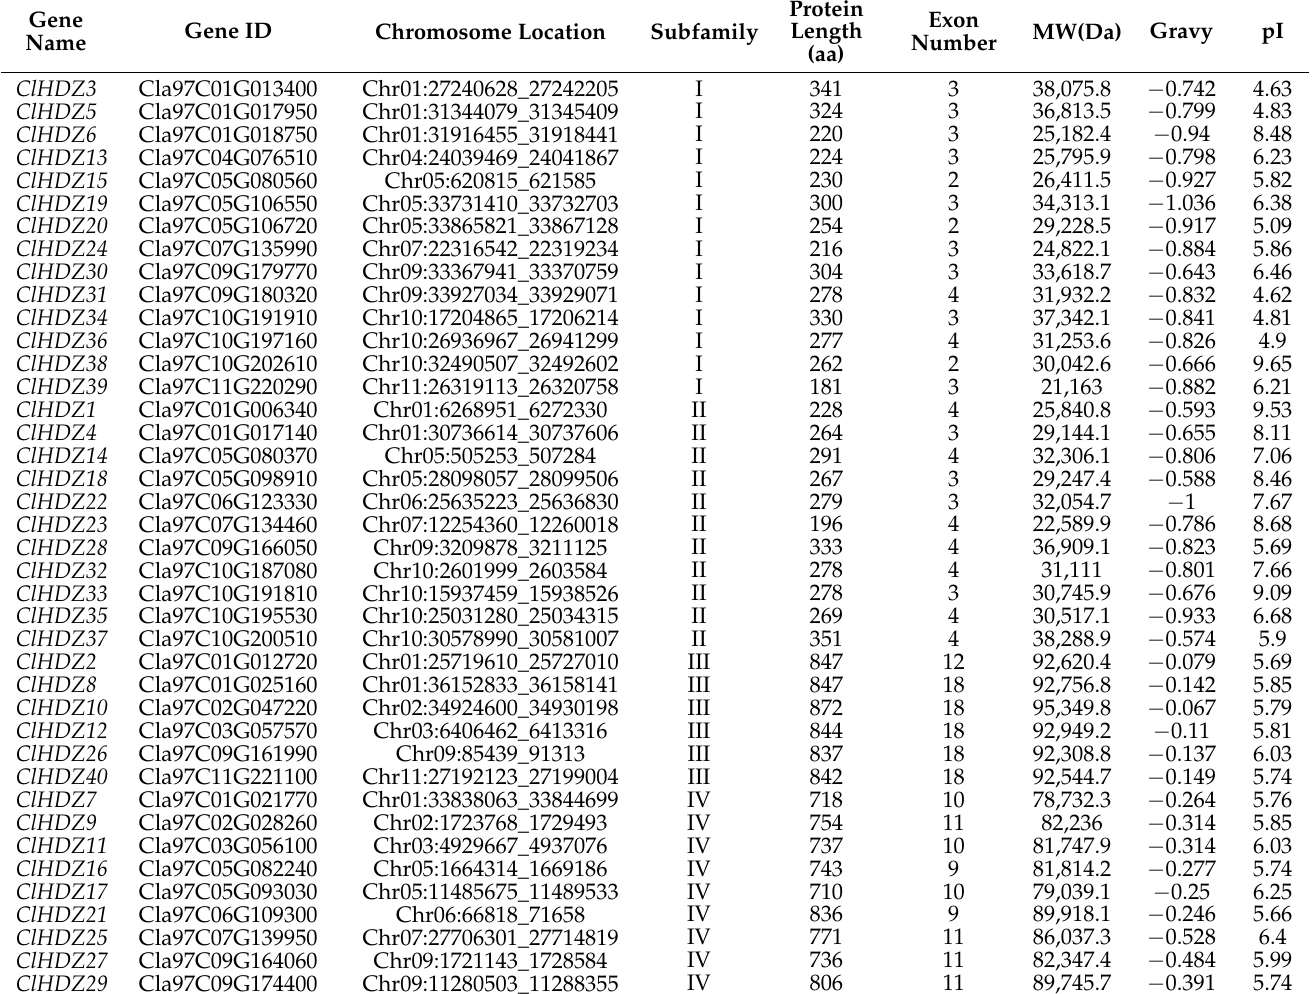
Table 1. The gene and protein features of HD-ZIP members in